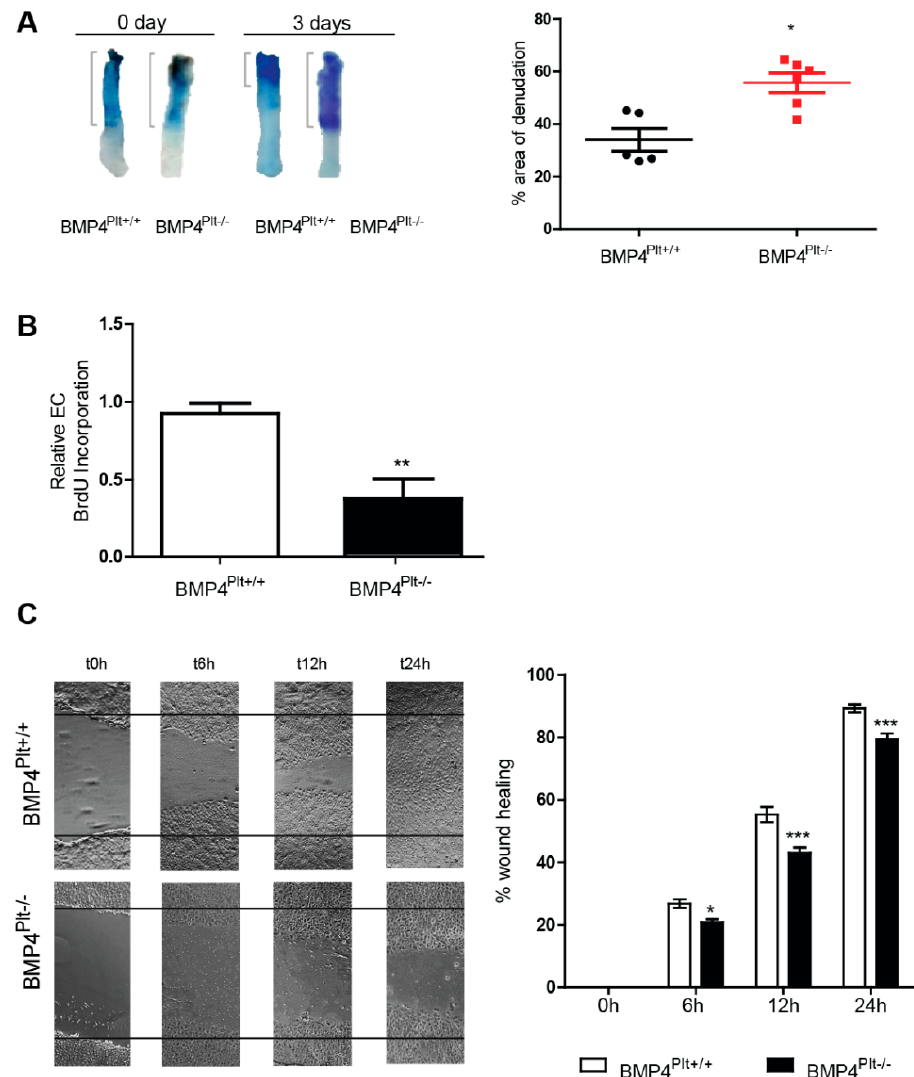
Figure 2. Platelet BMP-4 mediates re-endothelialization, endothelial cell proliferation and migration. ( A ) En-face staining of the denuded carotid with Evans blue after wire injury in BMP4 Plt − / − mice ( n = 6) and control ( n = 5). ( B ) Proliferation assay of endothelial cells stimulated with platelets (2 × 10 7 per well) isolated from BMP4 Plt − / − mice or control littermates. n = 5 per group. ( C ) Wound healing of MCECs treated with platelets (1 × 10 8 per well) isolated from BMP4 Plt − / − mice ( n = 6 independent experiments) or control littermates ( n = 5 independent experiments). * p ≤ 0.05; ** p ≤ 0.01; *** p ≤ 0.001.